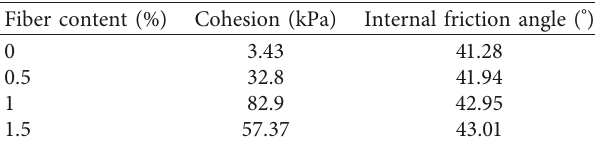
Table 4: Shear strength parameters of fiber-reinforced fly ash-soil